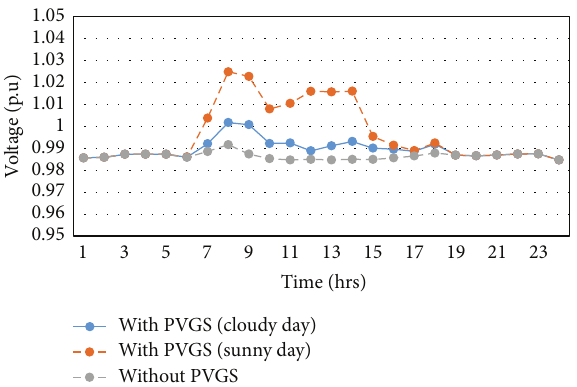
Figure 12: Hourly power generation and load demand for cloudy day.